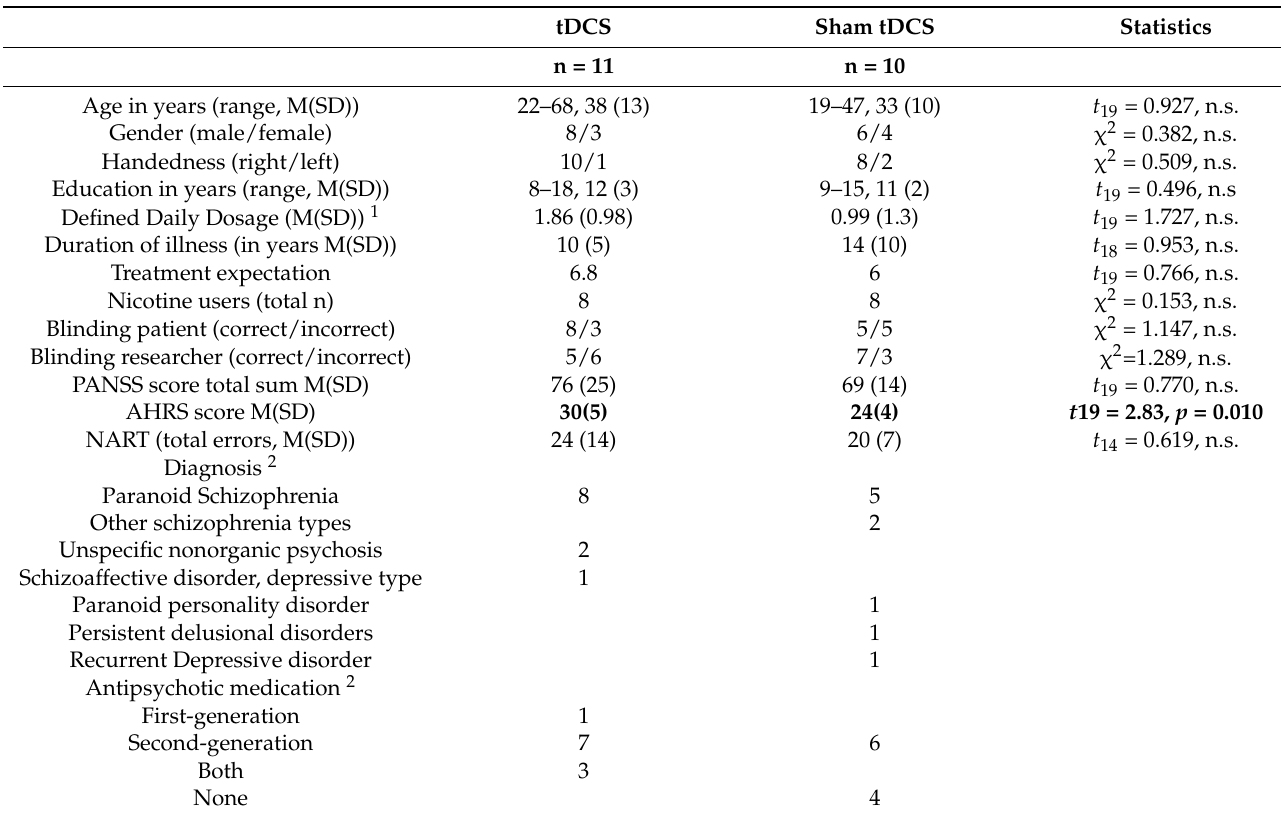
Table 1. Sample demographics at